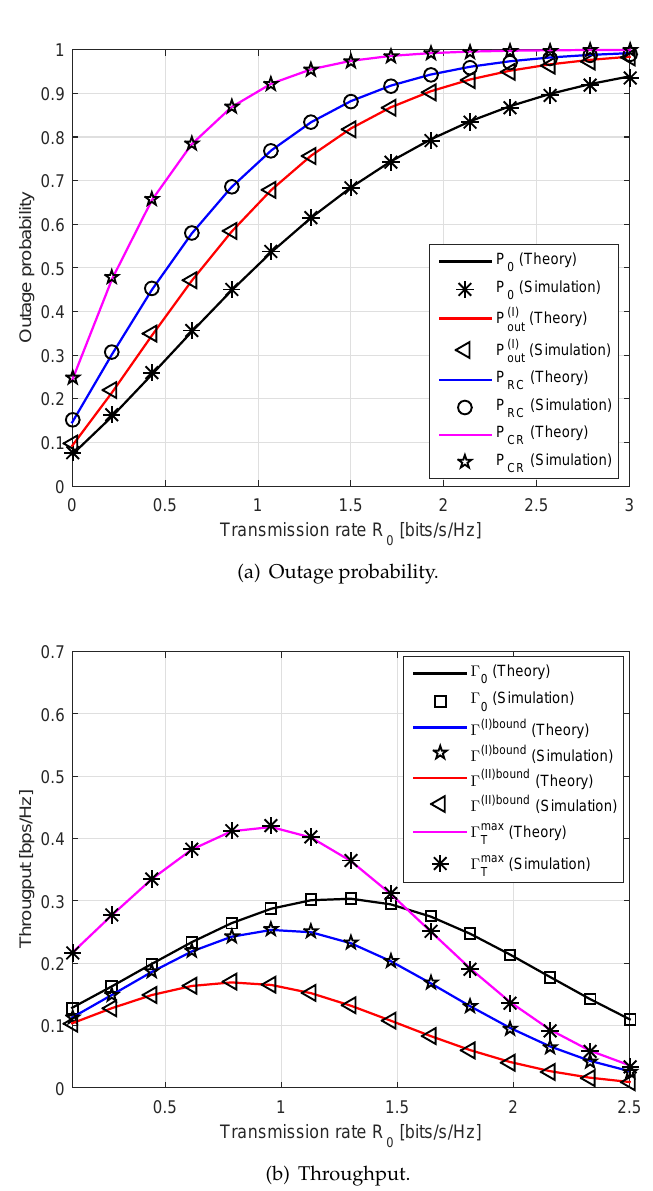
Figure 5. The outage probability and the throughput performance versus the transmission rate R 0